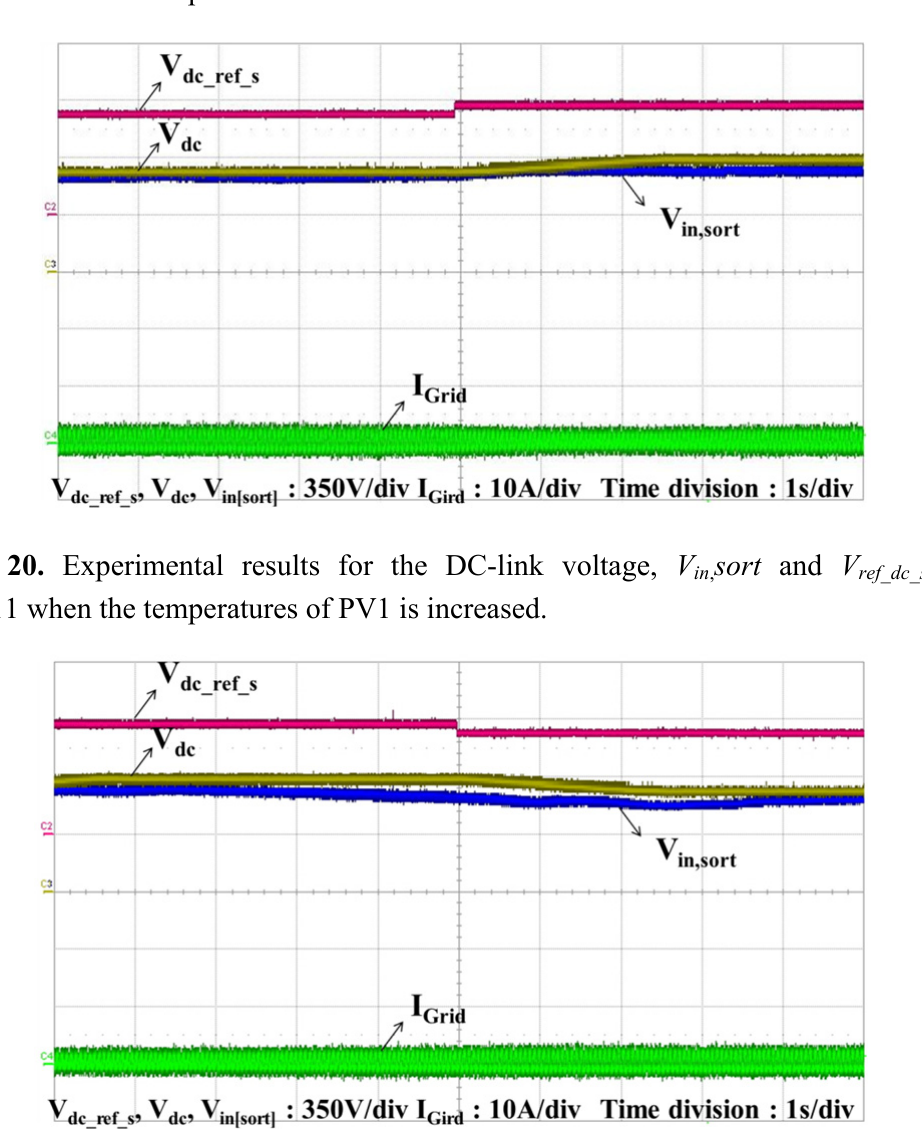
sort and V from in , ref_dc_s